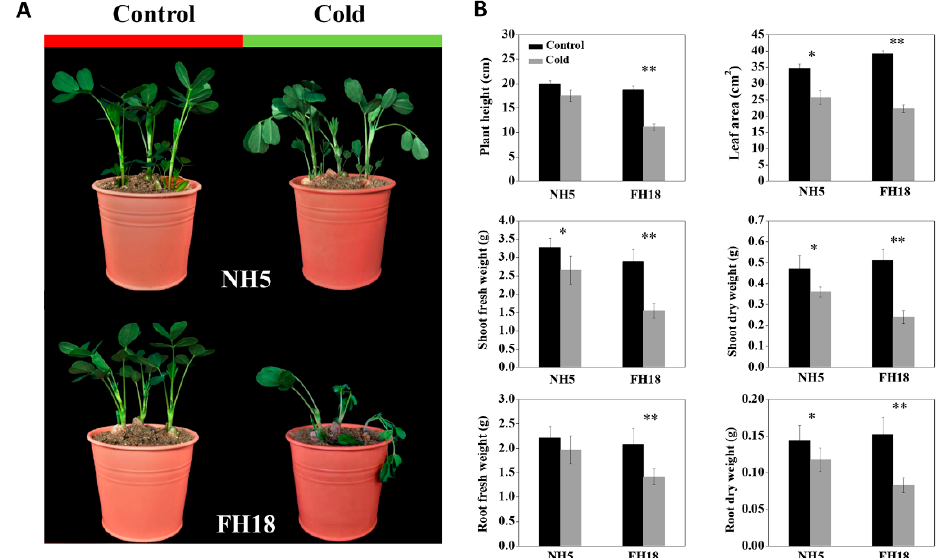
Figure 1. The changes in phenotype and morphology before and after cold treatment in Nonghua5 (NH5) and Fuhua18 (FH18). ( A ) Phenotypes of NH5 and FH18 under control and cold conditions, respectively. ( B ) Morphological indexes of NH5 and FH18 under control and cold conditions including plant height, leaf area, shoot fresh weight, shoot dry weight, root fresh weight, and root dry weight. Error bars represent the SD of the means ( n = 3). * p < 0.05; ** p < 0.01.